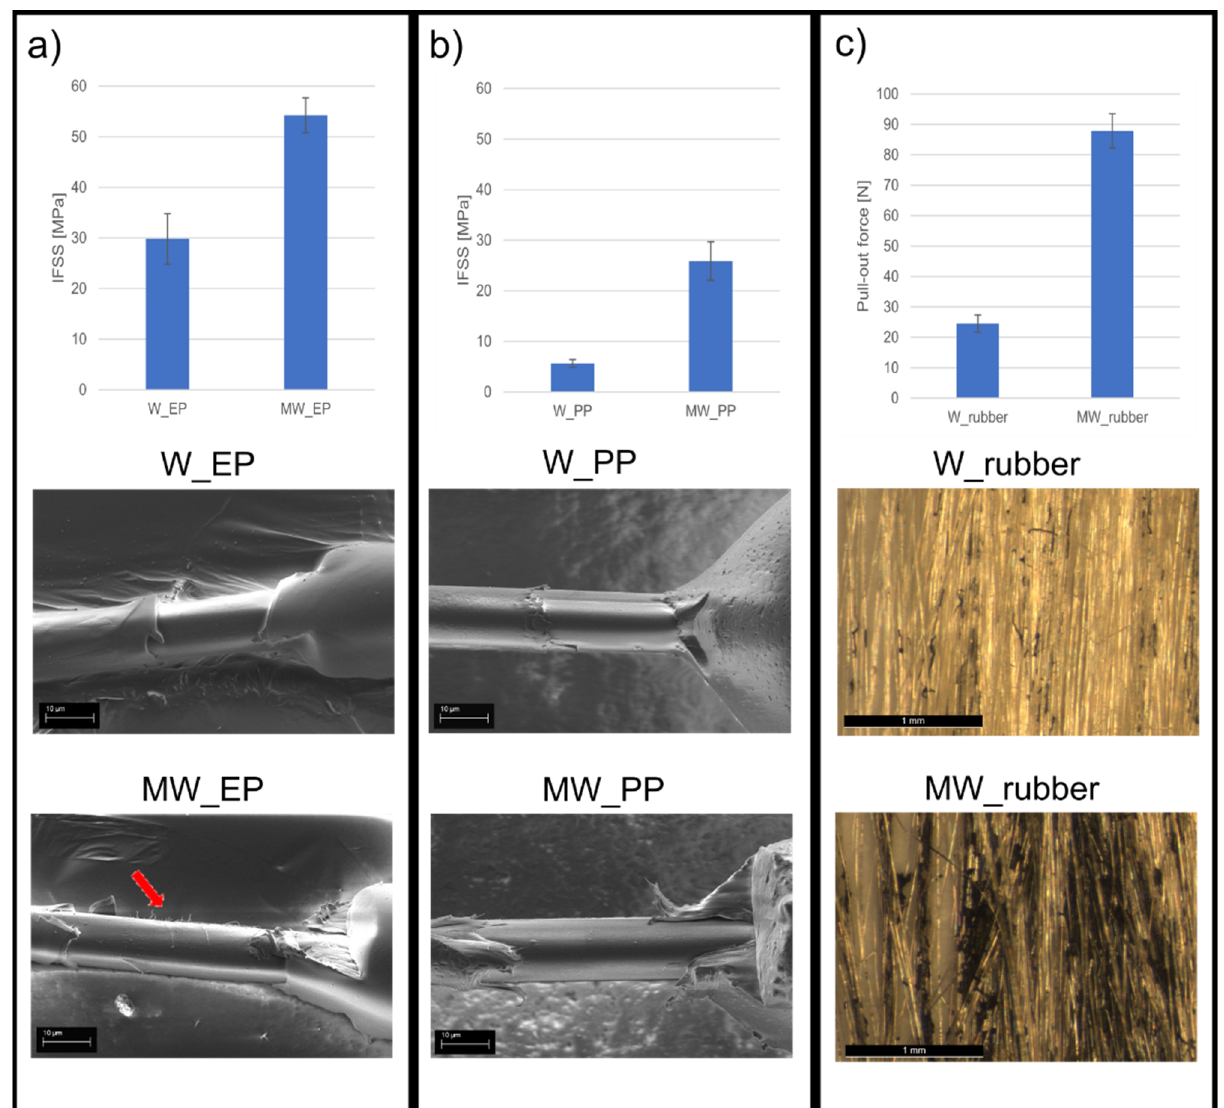
Figure 5. The IFSS results and SEM images of the corresponding fracture surfaces for ( a ) W_EP and MW_EP, where the arrow indicates fibrillation of the fiber surface, and ( b ) W_PP and MW_PP. The fiber bundle pull-out force and corresponding optical images are presented in ( c ) for W_rubber and MW_rubber